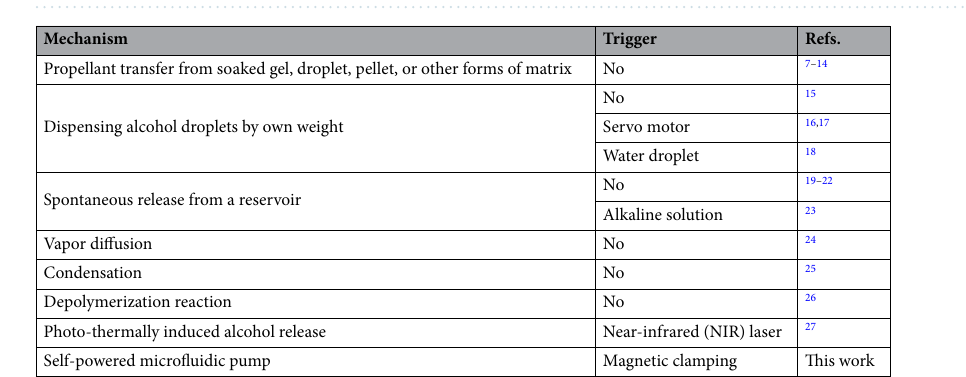
Figure 1. Structure and working principle of the robot exploiting Marangoni propulsion. ( A ) Secretion of chemicals that reduce surface tension. ( B ) The proposed self-propelling robot (bottom-right corner: a keel- extruded footpad). ( C ) The rear side of the robot. ( D ) The preparative steps prior to pump activation. ( E ) A cross-section of the air-filled chamber of D-(step 4). ( F ) Alcohol droplet formation during pump operation ( D O = 1.5 mm).